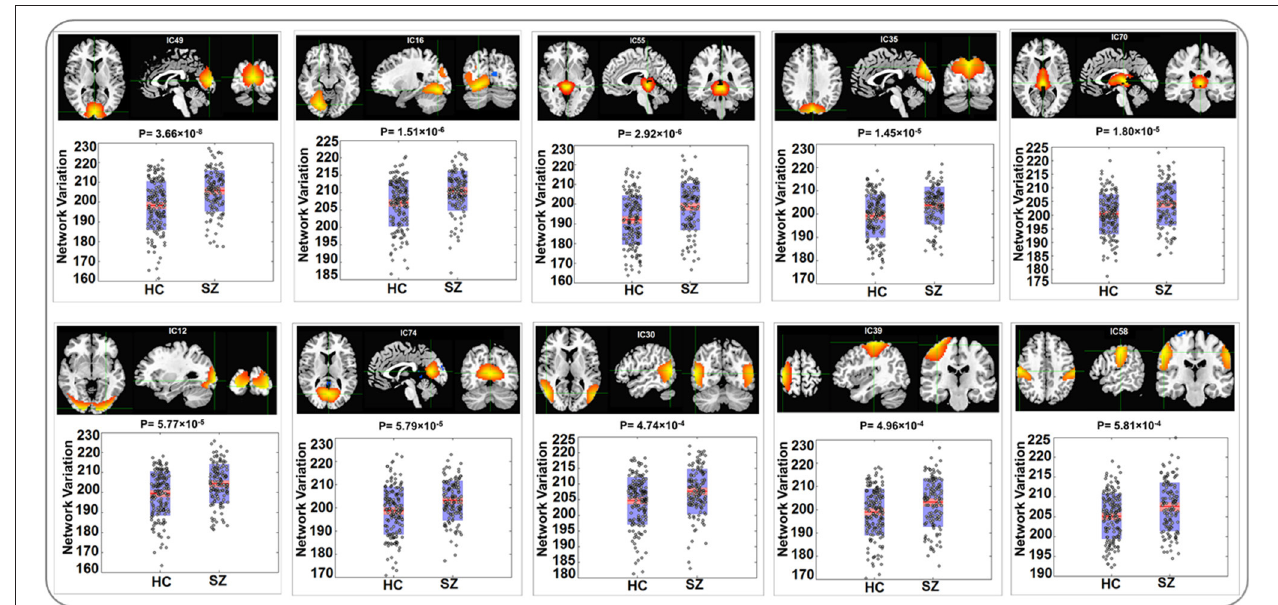
Frontiers in Neuroscience |